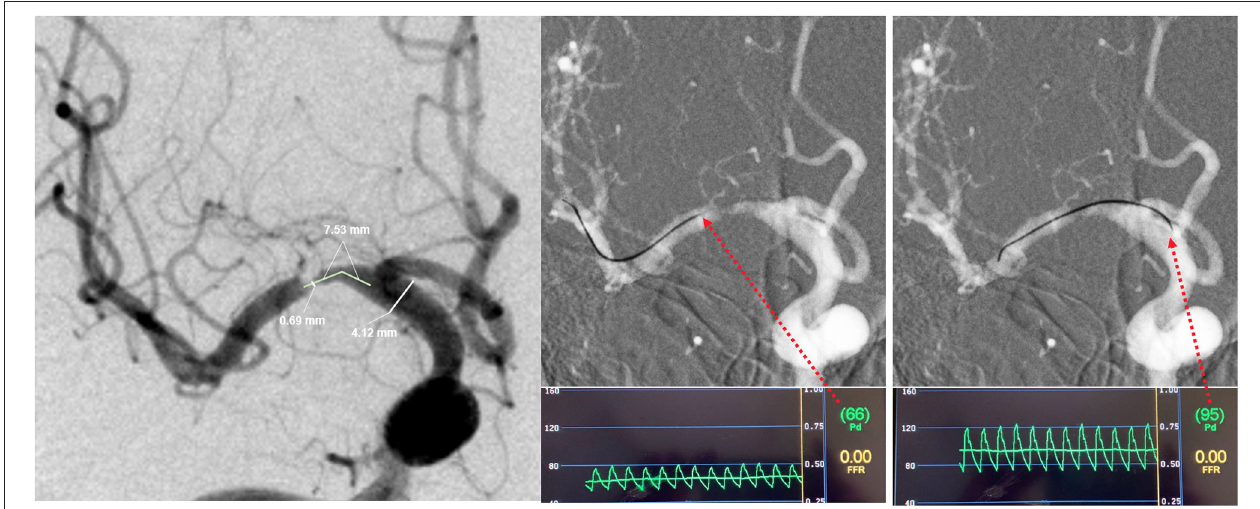
FIGURE 1 | Representative case of intracranial lesion geometry and translesional pressure measurements. In this patient, (A) the minimal lumen diameter was 0.69mm, and the normal segment diameter was 4.12mm, so the stenosis was calculated as 83.3%, and the lesion length was 7.53mm; (B) the mean distal pressure (Pd) was 66 mmHg; (C) the mean proximal pressure (Pa) was 95 mmHg. The translesional pressure gradient radio (Pd/Pa) and translesional pressure gradient difference (Pa–Pd) were thus found to be 0.69 and 29 mmHg.